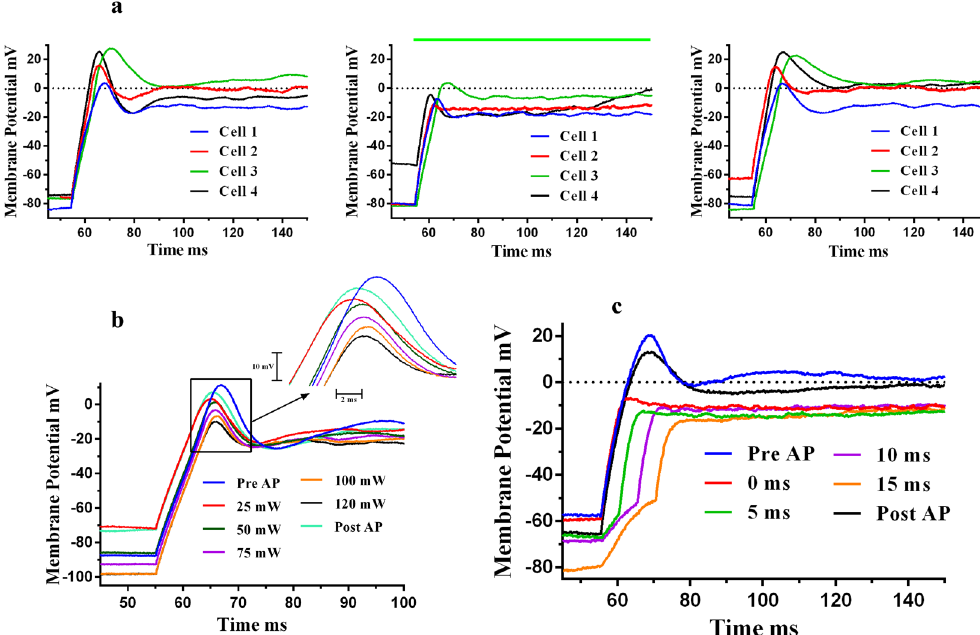
Figure 5. Inhibition of action potentials of SH-SY5Y neural cells - Whole Cell Current Clamp Recording. When laser pulses were superimposed on the responses to electric current pulses, a reduction in magnitude of action potentials was observed. ( a ) The figures show responses for four different cells. Left: Action potentials (Pre-AP) recorded when cells were stimulated with electric current pulses, (180 pA, 300 ms) – control conditions. Middle: A 300 ms, 120 mW, 532 nm green laser pulse (shown by green bar) was superimposed on the electric current pulse (180 pA, 300 ms), cell shows a reduction in the amplitude of action potential. Right: Action potential recorded post laser experiments, returns to the original value. The temp. rise of around 20 K was experienced by ~5–10% cell area. ( b ) The inhibition of action potential is affected by laser power. As laser power increases, inhibition becomes more prominent - AP peak decreases with laser power. The pulse width was 300 ms. ( c ) The inhibition of action potential is more prominent when the laser pulse led the electrical pulse by a few milliseconds as shown in a representative